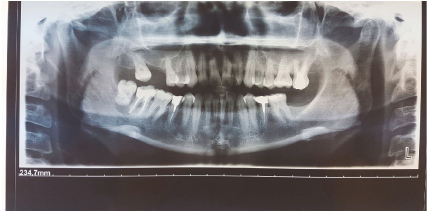
Figure 1: Initial radiography.